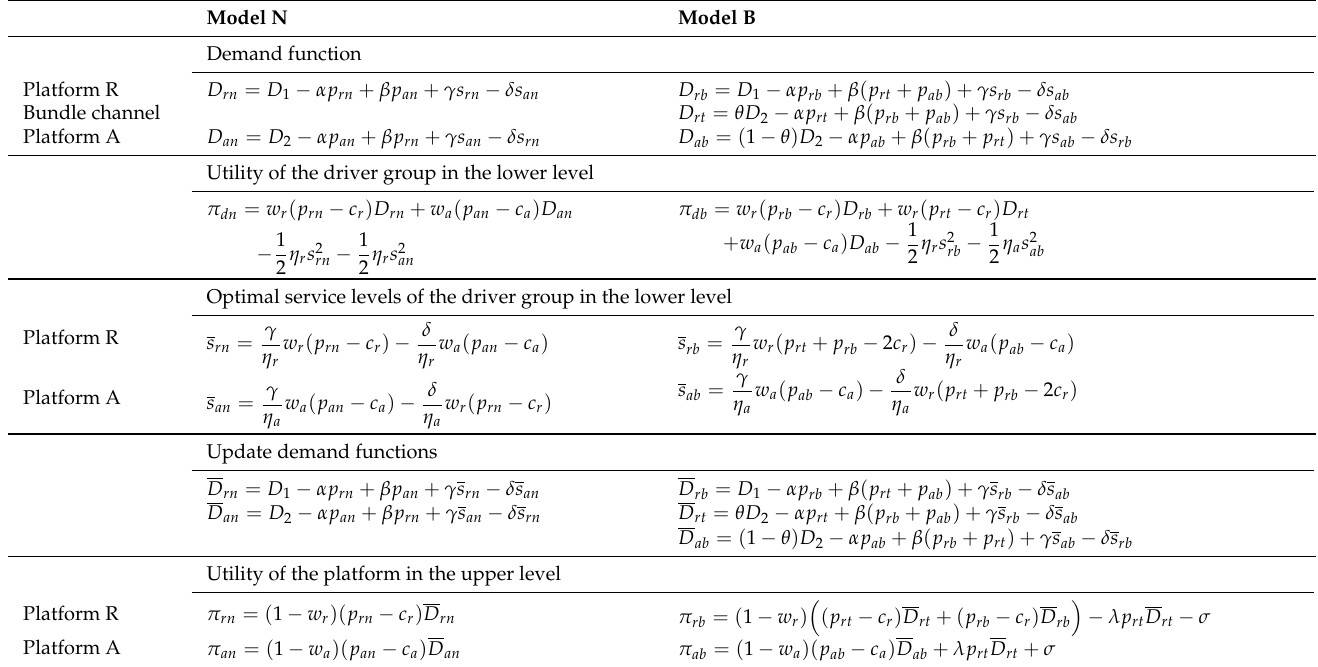
Table 3. Expressions of Model N and Model